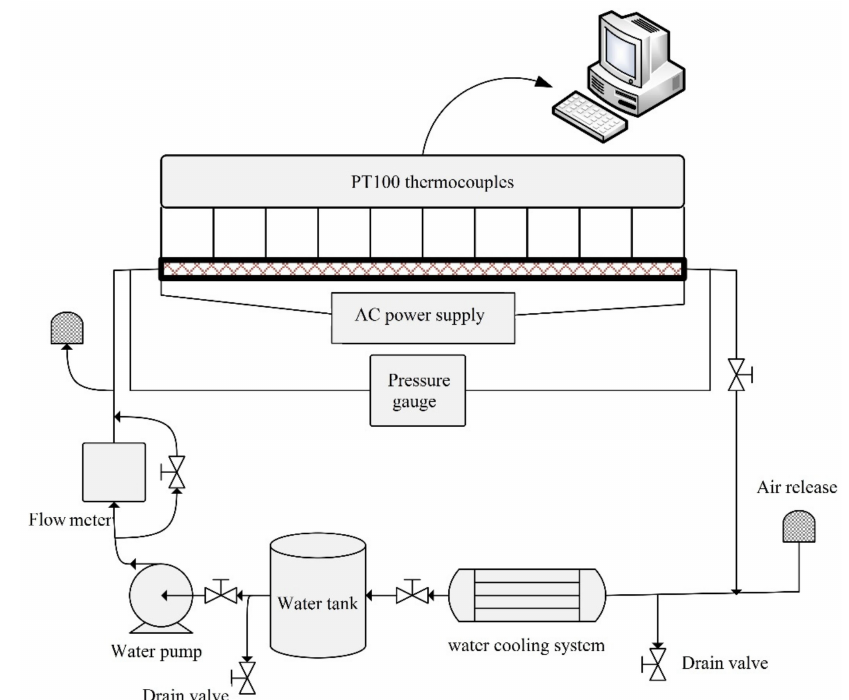
Figure 1. Schematic of experimental setup configuration